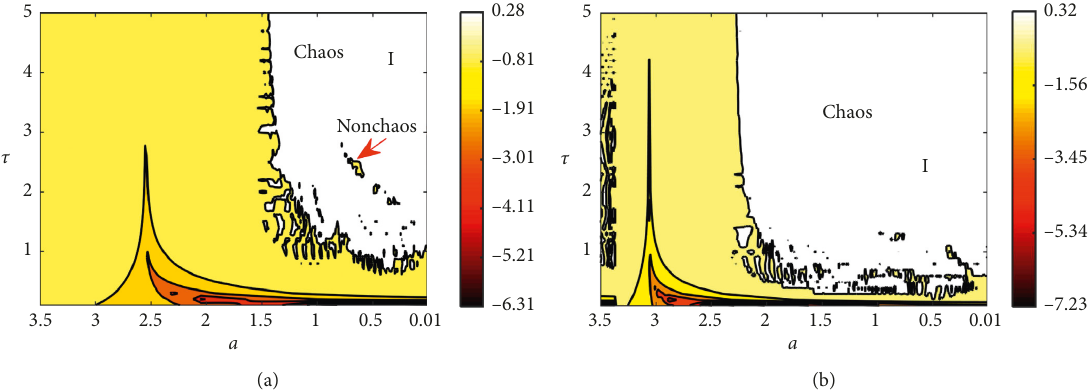
Figure 9: (a) The 2D LE diagram showing the largest Lyapunov exponent ( λ diagram showing the largest Lyapunov exponent of the ACCM-Ikeda TD system in the ( a − τ )